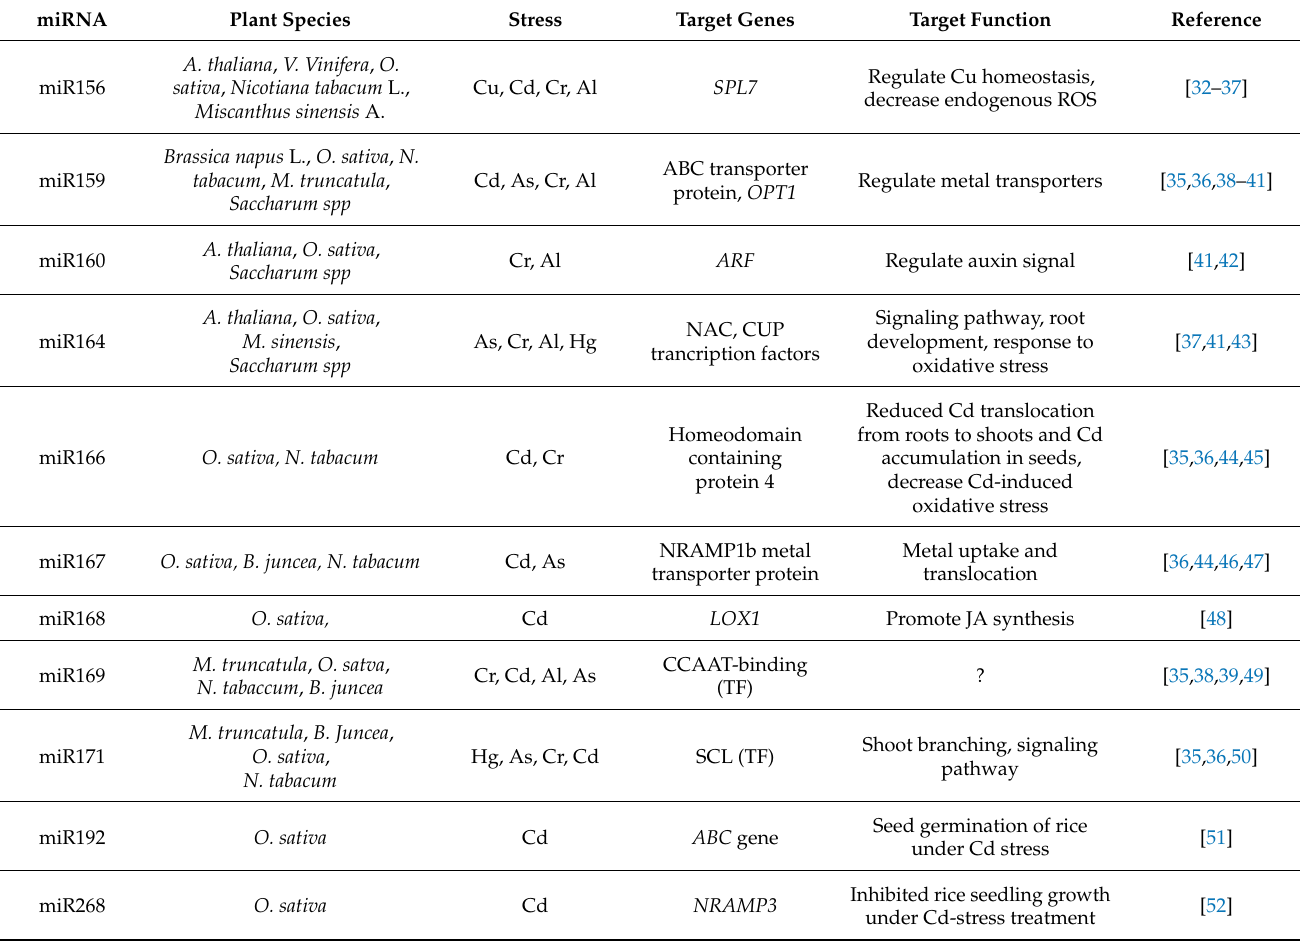
Table 1. List of miRNAs along with their target function during heavy metal toxicity tolerance. Plant Species Stress Target Genes Target Function